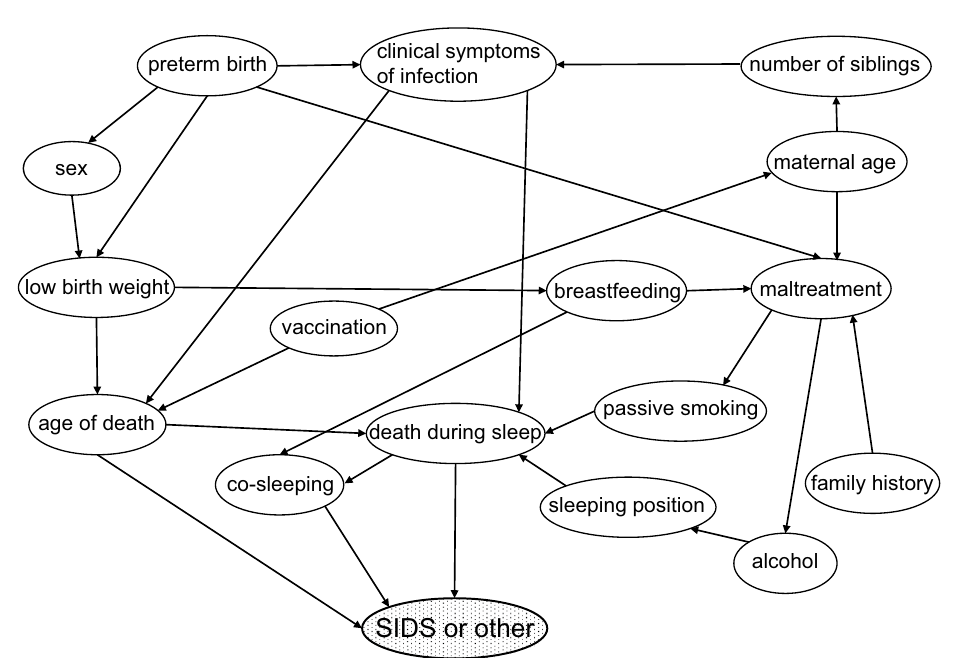
Figure 3. A Bayesian diagnostic support model for SIDS. This model reflects the relationship among risk factors leading to death (cf. Supplementary Fig. S2). A conditional probability table was created for each factor. Including the presence or absence of each factor enables the calculation of SIDS diagnosis probability. SIDS, sudden infant death